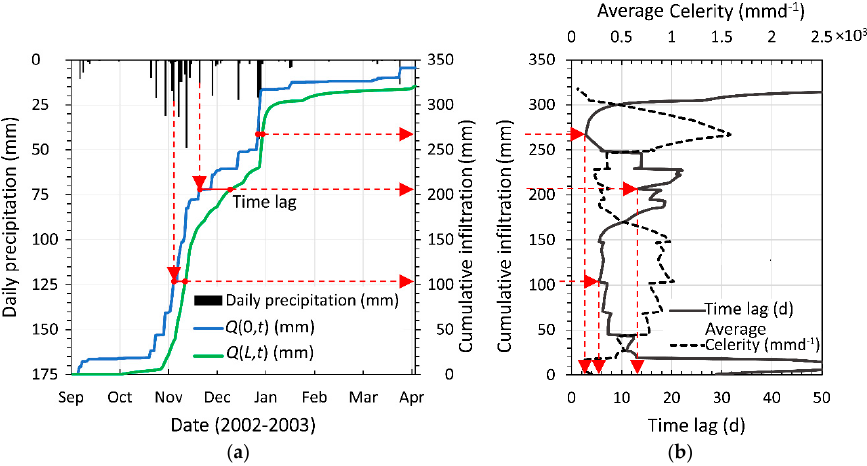
Figure 10. ( a ) Daily precipitation (mm), cumulative infiltration at topsoil Q (0, t ) (mm) and